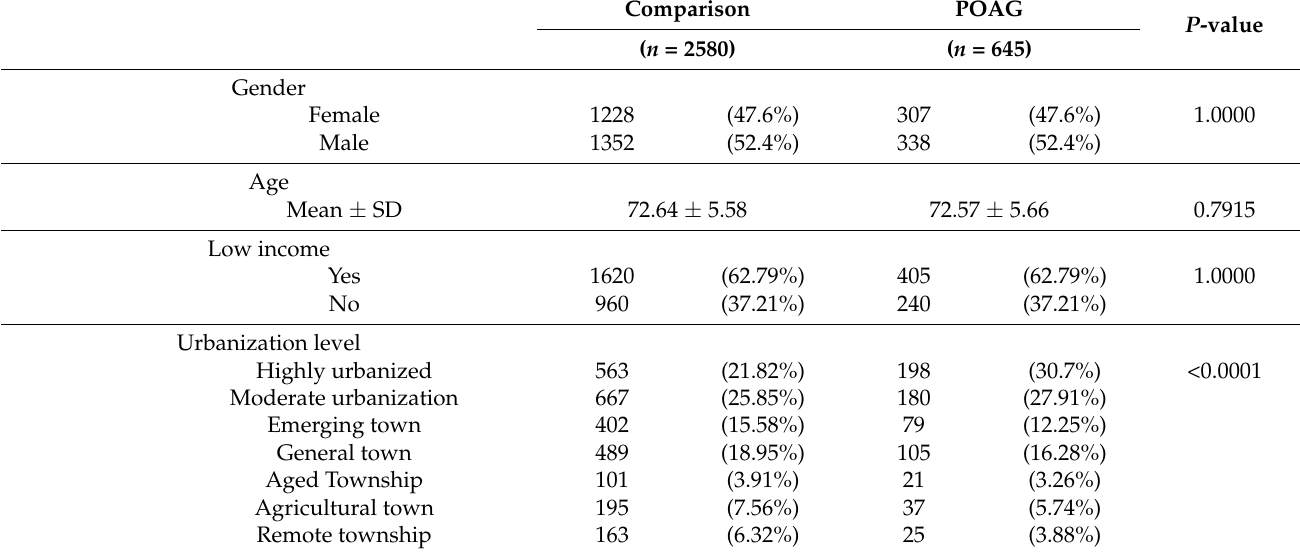
Table 1. Baseline characteristics of participants of primary open-angle glaucoma (POAG) and comparison.